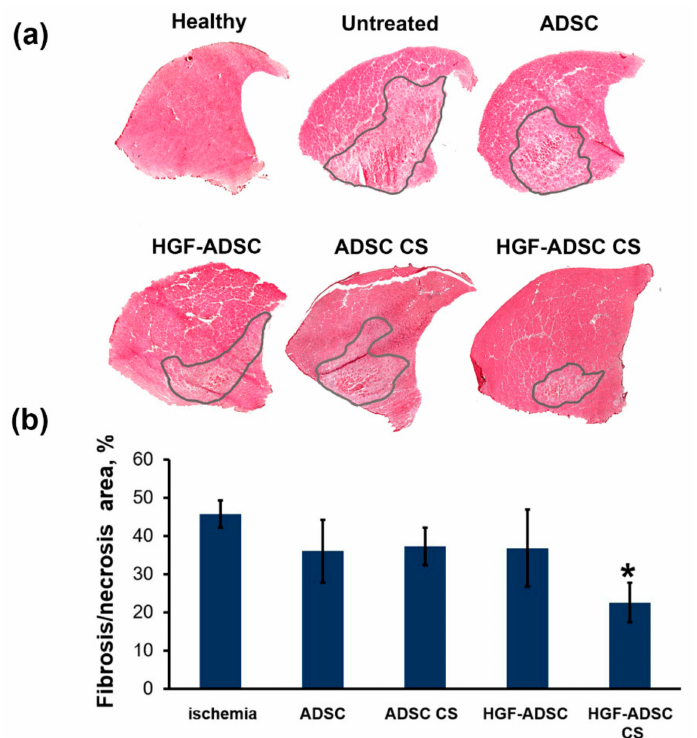
Figure 6. Morphometric analysis of necrosis / fibrosis in ischemic muscle at day 14 after ischemia induction and cell sheets / cells transplantation. ( a ) Whole-section images of hematoxylin / eosin stained m. tibialis anterior . Necrotic / fibrotic tissue is marked by a line; ( b ) graphical presentation of necrotic / fibrotic tissue span. Data are presented as mean ± SEM (Mann–Whitney U-test; * p = 0.025 vs. untreated ischemic group). HGF = hepatocyte growth factor, CS = cell sheet, ADSC = adipose-derived stromal